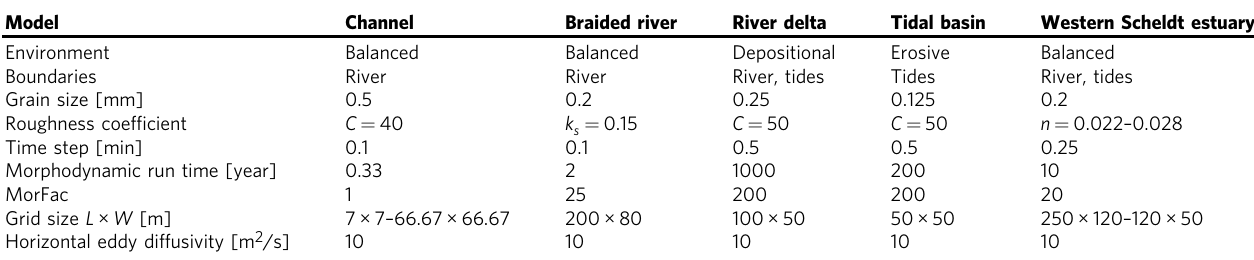
Table 1 Overview of the default physical and numerical parameters of interest for all fi ve Delft3D models used in this study